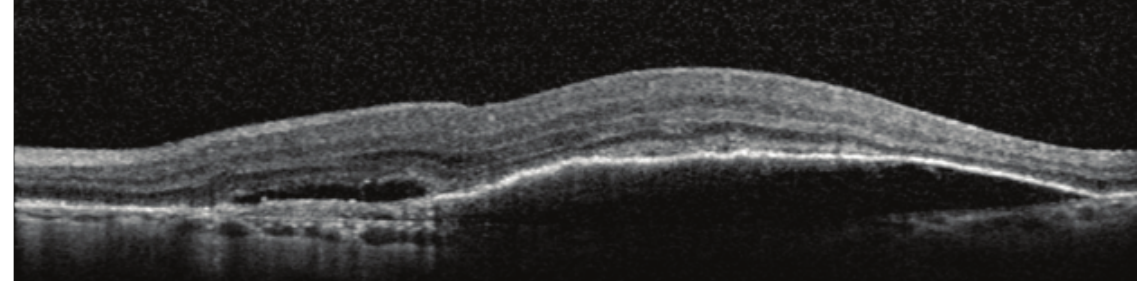
Figure 5. Macular optical coherence tomography at the first postoperative month demonstrating a resolving submacular hemorrhage and retinal pigment epithelium